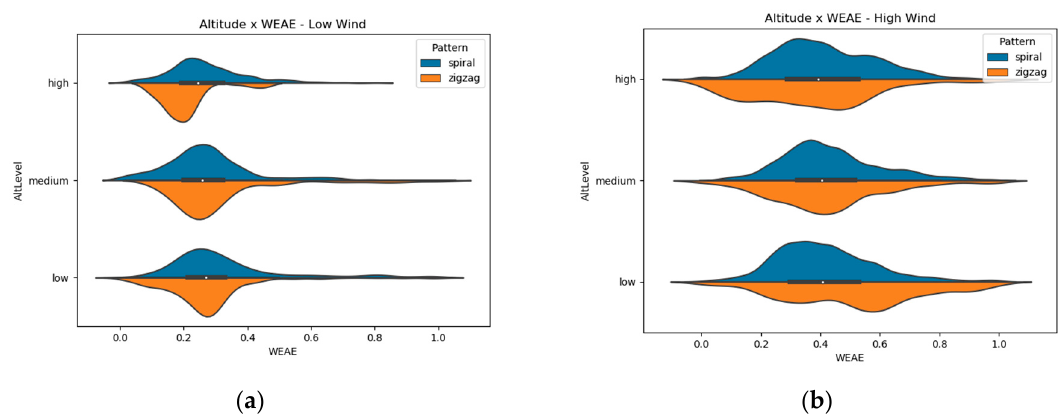
Figure 8. Violin plots of gas measurements at each layer of altitude for ( a ) Low Wind conditions and ( b ) High Wind conditions.